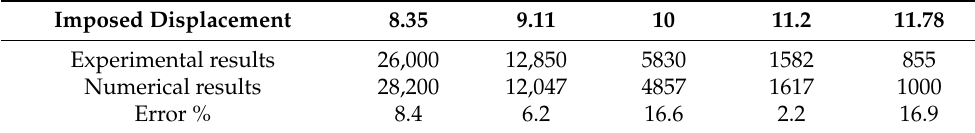
Figure 15. Simulated damage evolution at the extreme fi xed outer layer of PA66GF20 specimens.